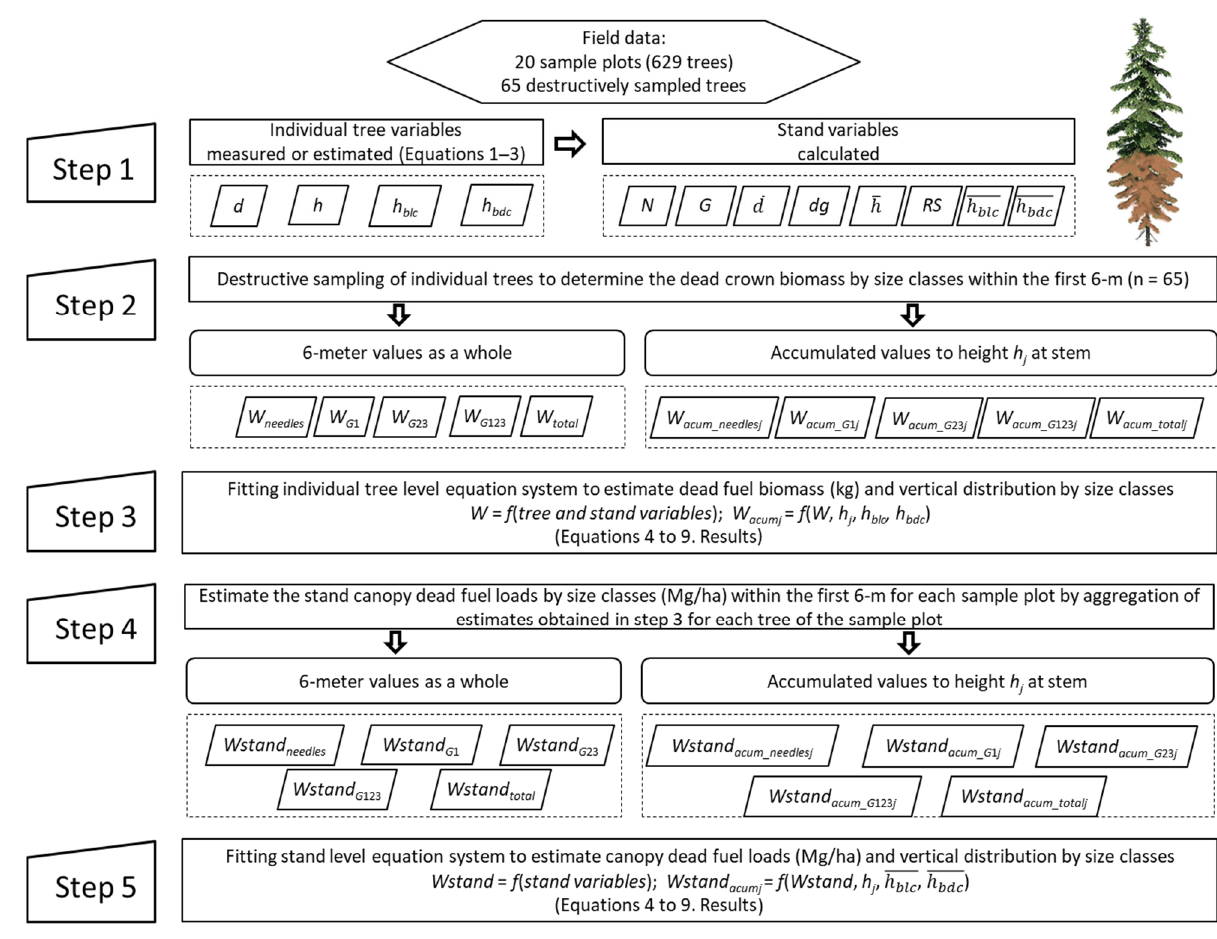
Figure 2. Workflow for fitting the equation systems at individual tree and stand levels.